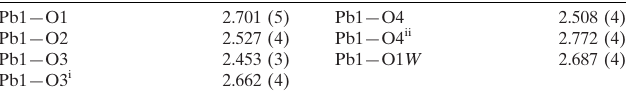
Selected bond lengths (A˚ ).